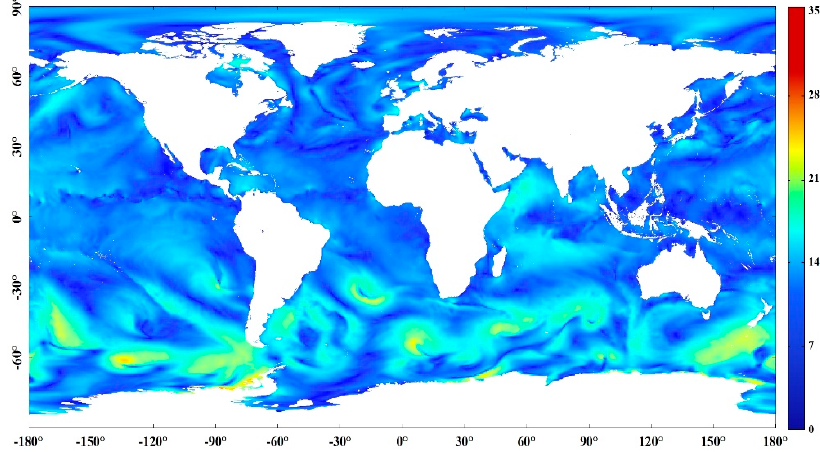
Figure 9. Map of global wind speeds (m/s) at 12:30 (UTC time) on 1 July 2003.